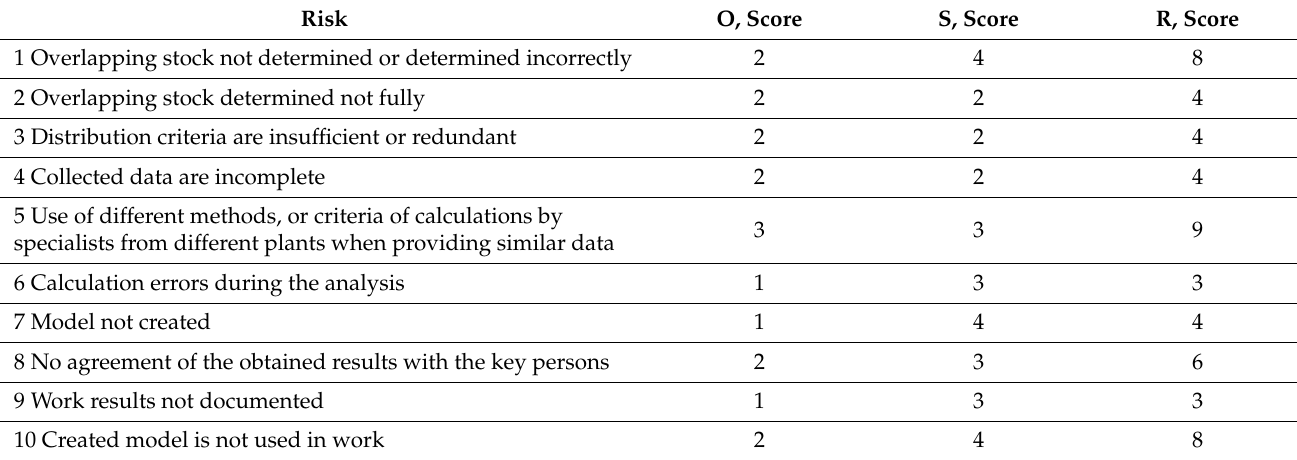
Table 6. Results of assessing the indicators of the risks of the process under study. Risk O, Score S, Score R,